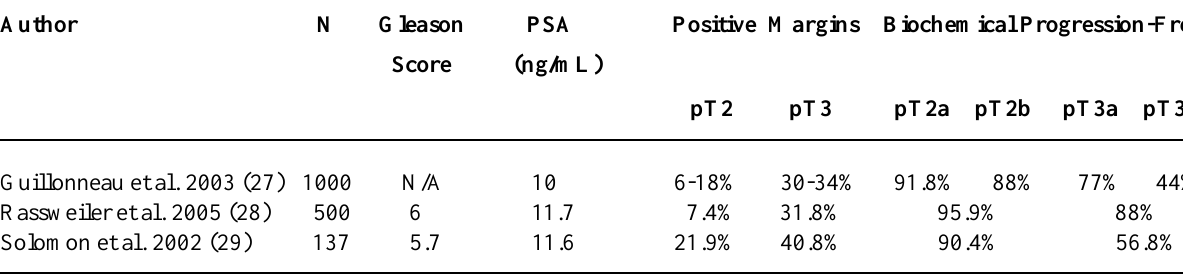
Table 5 – Laparoscopic radical prostatectomy series oncological